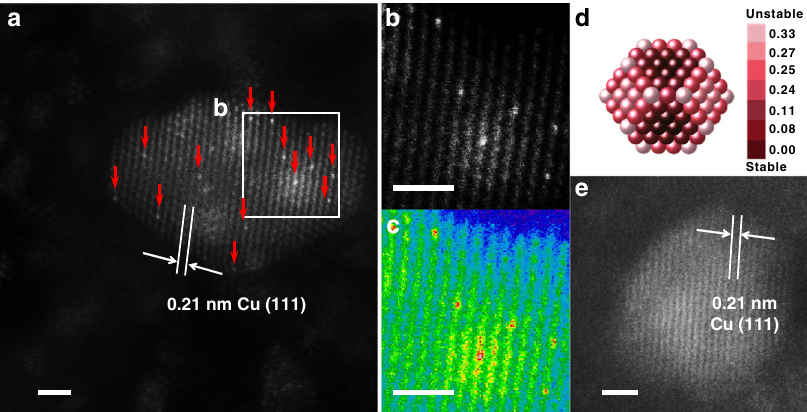
Fig. 4 Morphology of γ -Al 2 O 3 -supported Pt/Cu SAA. a HAADF-STEM images with typical region of the reduced 0.1Pt10Cu/Al 2 O 3 catalyst, showing Pt atoms individually dispersed on Cu(111). Pt atoms are highlighted by red arrows. b , c The enlarged image and the colored intensity map from the selected region in a . The lattice spacing of Pt/Cu SAA is 0.21 nm, which is consistent with that of Cu(111). d Relative stability of Pt single atoms over Cu (~2.1 nm) nanoparticle: dark red indicates stable location of Pt atom. Color bar unit is eV/Pt atom. e HAADF-STEM images with typical region of the reduced 10Cu/ Al 2 O 3 catalyst, showing no Pt atoms existing on the surface of Cu nanoparticles. Scale bars, 1 nm ( a ), ( b ), ( c ) and ( e